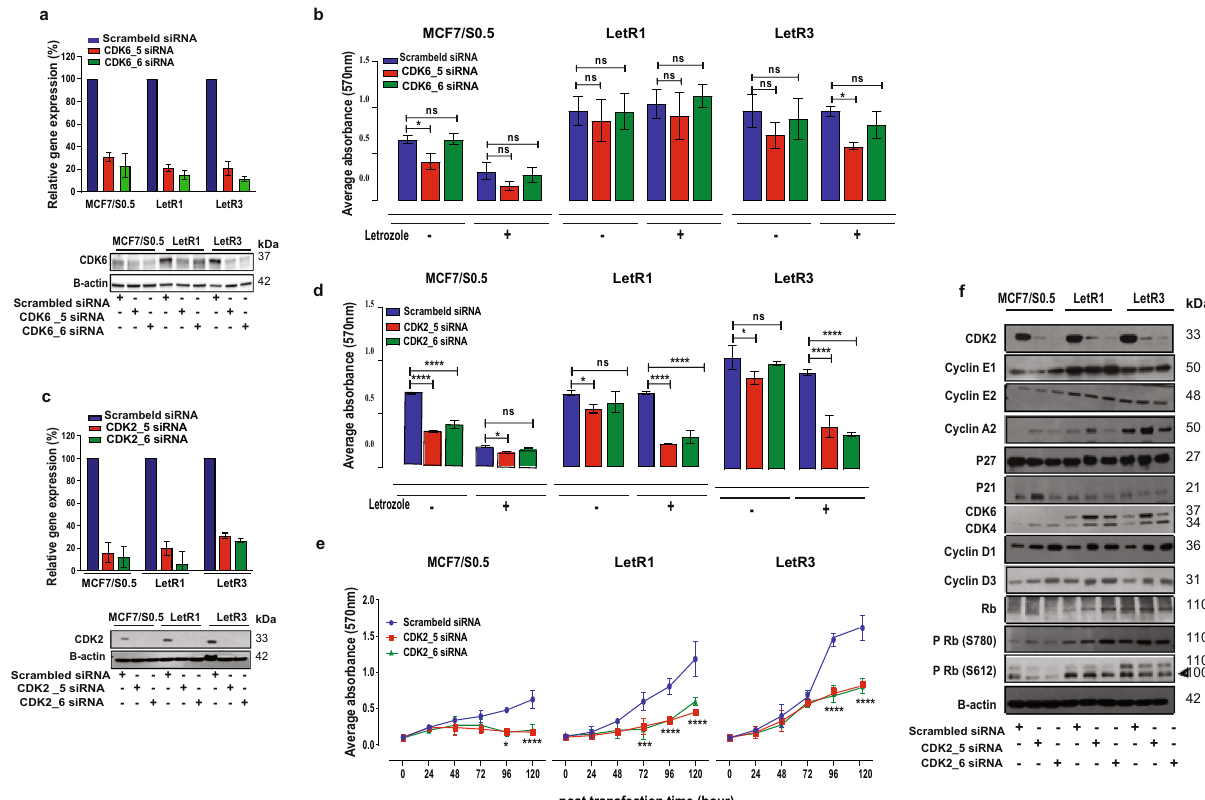
Fig. 2 siRNA-mediated CDK2 knockdown re-sensitizes letrozole-resistant cells to letrozole. The effect of CDK2 or CDK6 silencing in letrozole-resistant (LetR) and parental MCF7/S0.5 cells transfected with two different CDK6-speci fi c (CDK6_5 and CDK6_6), CDK2-speci fi c (CDK2_5 and CDK2_6) or scrambled (control) siRNAs. a Quantitative RT-PCR and western blotting verifying reduction of CDK6 at mRNA (48 h) and protein levels (96 h) post-transfection with CDK6-speci fi c siRNAs. The expression was normalized using PUM1 gene, while β -actin was used as protein loading control. b Cell growth in the presence or absence of letrozole 96 h post-transfection with CDK6-speci fi c siRNAs, as assessed by crystal violet assay. c Quantitative RT-PCR and western blotting verifying reduction of CDK2 at mRNA (48 h) and protein levels (96 h) post- transfection with CDK2-speci fi c siRNAs. The expression was normalized using PUM1 gene and β -actin was used as protein loading control. d Cell growth in the presence or absence of letrozole at 96 h post-transfection, as assessed by crystal violet assay. e Cell growth in the presence of letrozole at different time points following CDK2-speci fi c siRNA transfection, as assessed by crystal violet assay. f Western blotting analysis of G1/S transition cooperative cascades at 96 h after CDK2-siRNA transfection in the absence of letrozole. β -actin was used as loading control. The cell growth is represented as average absorbance at 570 nm of triplicates mean ± SD. Statistically signi fi cant differences calculated by two-way ANOVA are shown as ns p > 0.05, * p ≤ 0.05, *** p ≤ 0.001, and **** p ≤ were also demonstrated by CellTiter-Blue, which measures the metabolic activity/viability of living cells (Supplementary Fig. 6a, b). Calculations of the combination index (CI) showed that CDK4/6i, AI and CDK2i exhibited synergistic activity when combined (Supple-